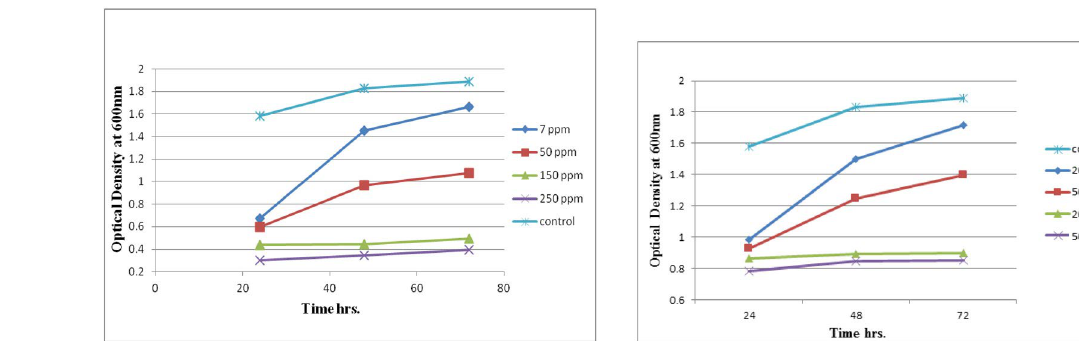
Fig. 10. Growth curve of isolate PS with (CdCl different concentrations.